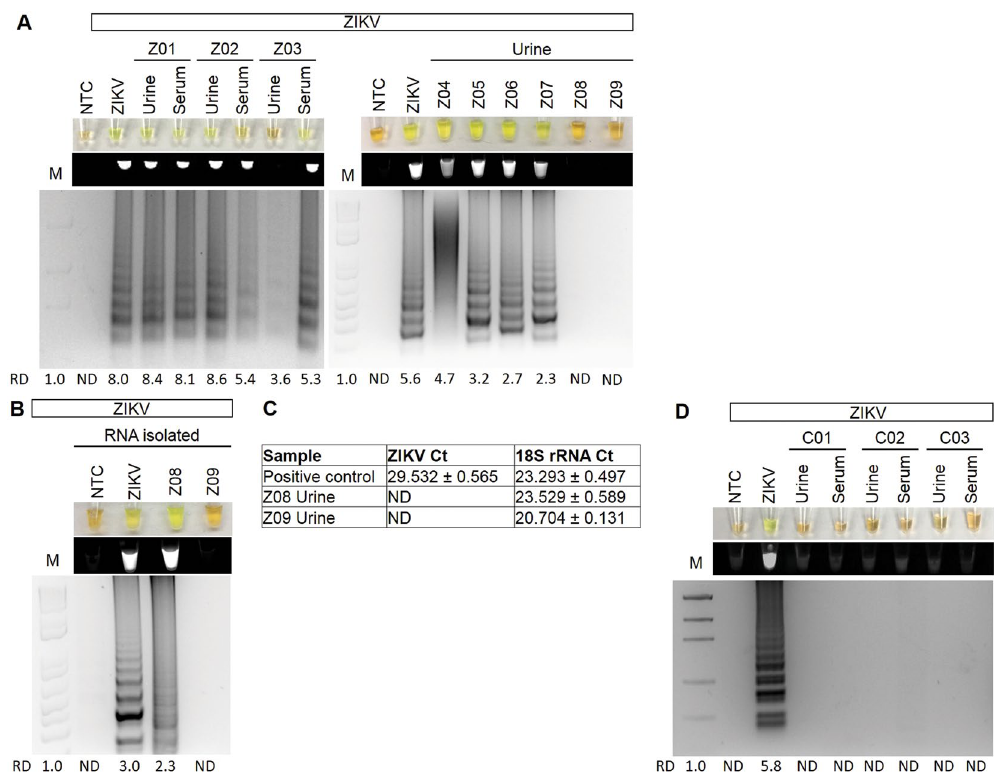
Figure 6. Examination of ZIKV and 18 s rRNA in human clinical samples. ( A ) ZIKV positive patient samples subjected to a ZIKV specific RT-LAMP reaction without ( A ) or with ( B ) RNA isolation then visualized by addition of SYBR Green I by eye (upper panel), green fluorescence (middle panel), or gel electrophoresis (bottom panel). Lane NTC: No template control (negative control); Lane ZIKV: ZIKV PCR Standard (ZIKV; Robert Koch Institute). Relative density (RD) of the entire bands for a column relative to the DNA Mass Marker are indicated below the corresponding lane. Lanes that did not have any detectable bands over background are reported as not detectable (ND). ( C ) Detection of ZIKV or ribosomal 18 S rRNA by qRT-PCR. Data shown as mean ± standard deviation. ( D ) ZIKV specific RT-LAMP in asymptomatic control